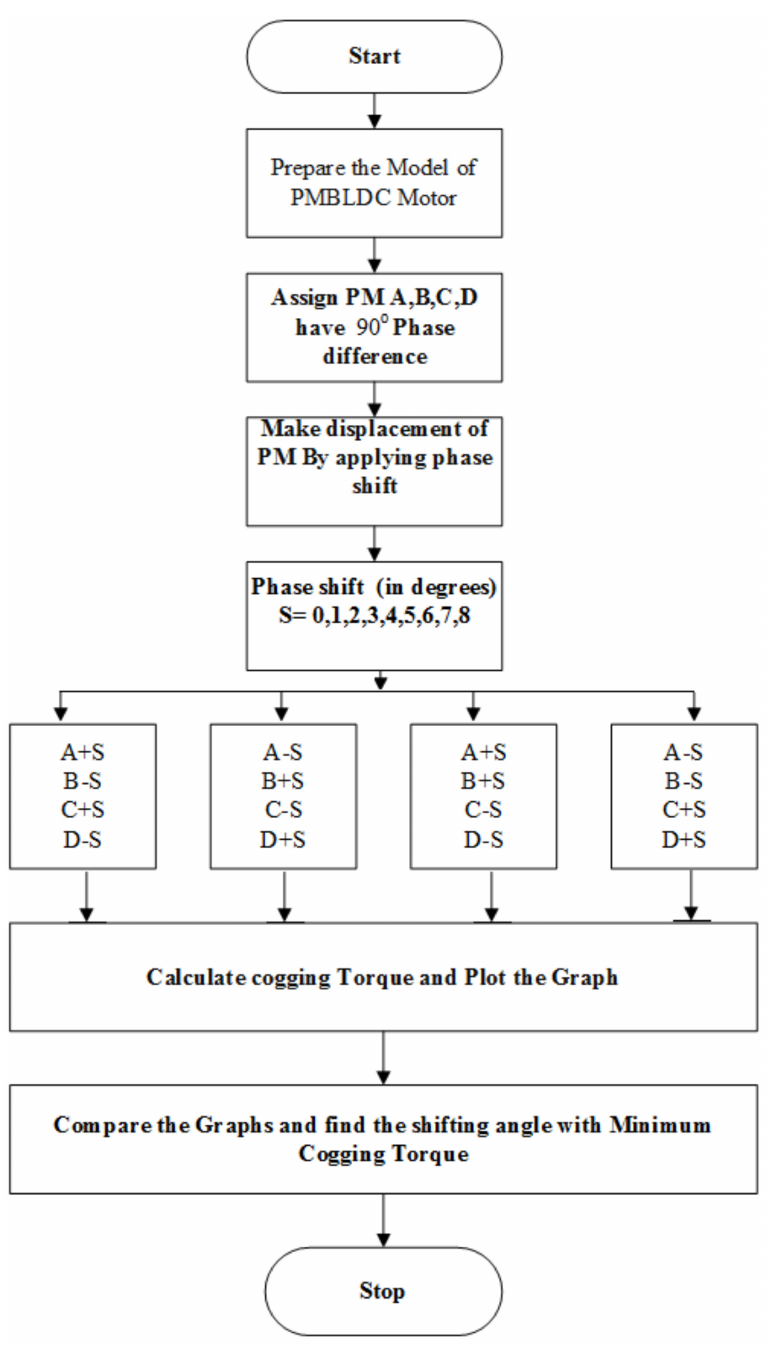
Figure 6. Flowchart for the procedure for finding shifting angle with minimum cogging